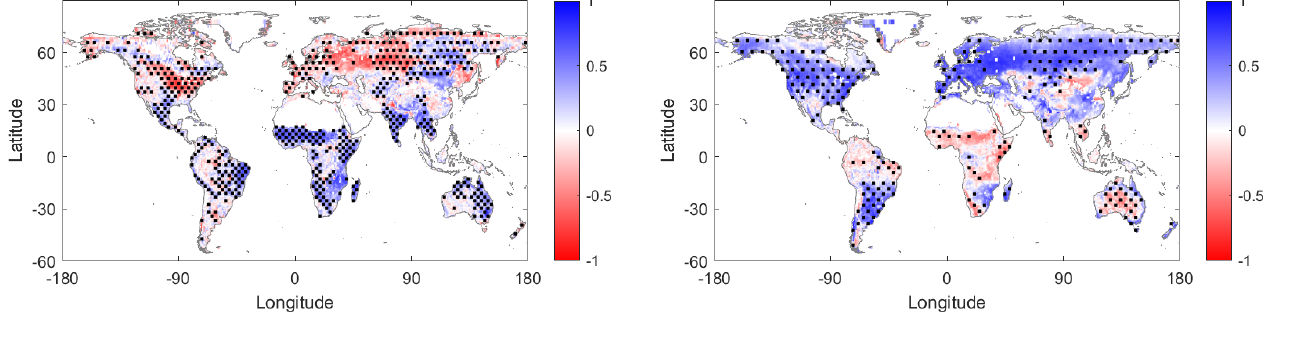
Figure 2. TROPOMI sun-induced chlorophyll fluorescence (SIF) and SMAP-MT-DCA soil moisture (SM) growing-season correla- tion. Pearson correlation coefficient of 8d averages. Regions of statistical significance ( P < 0 . 05) are indicated with stippling. The stippling corresponds to distributed areas of statistically significant grid points, and therefore each statistically significant pixel may not have its own dot.